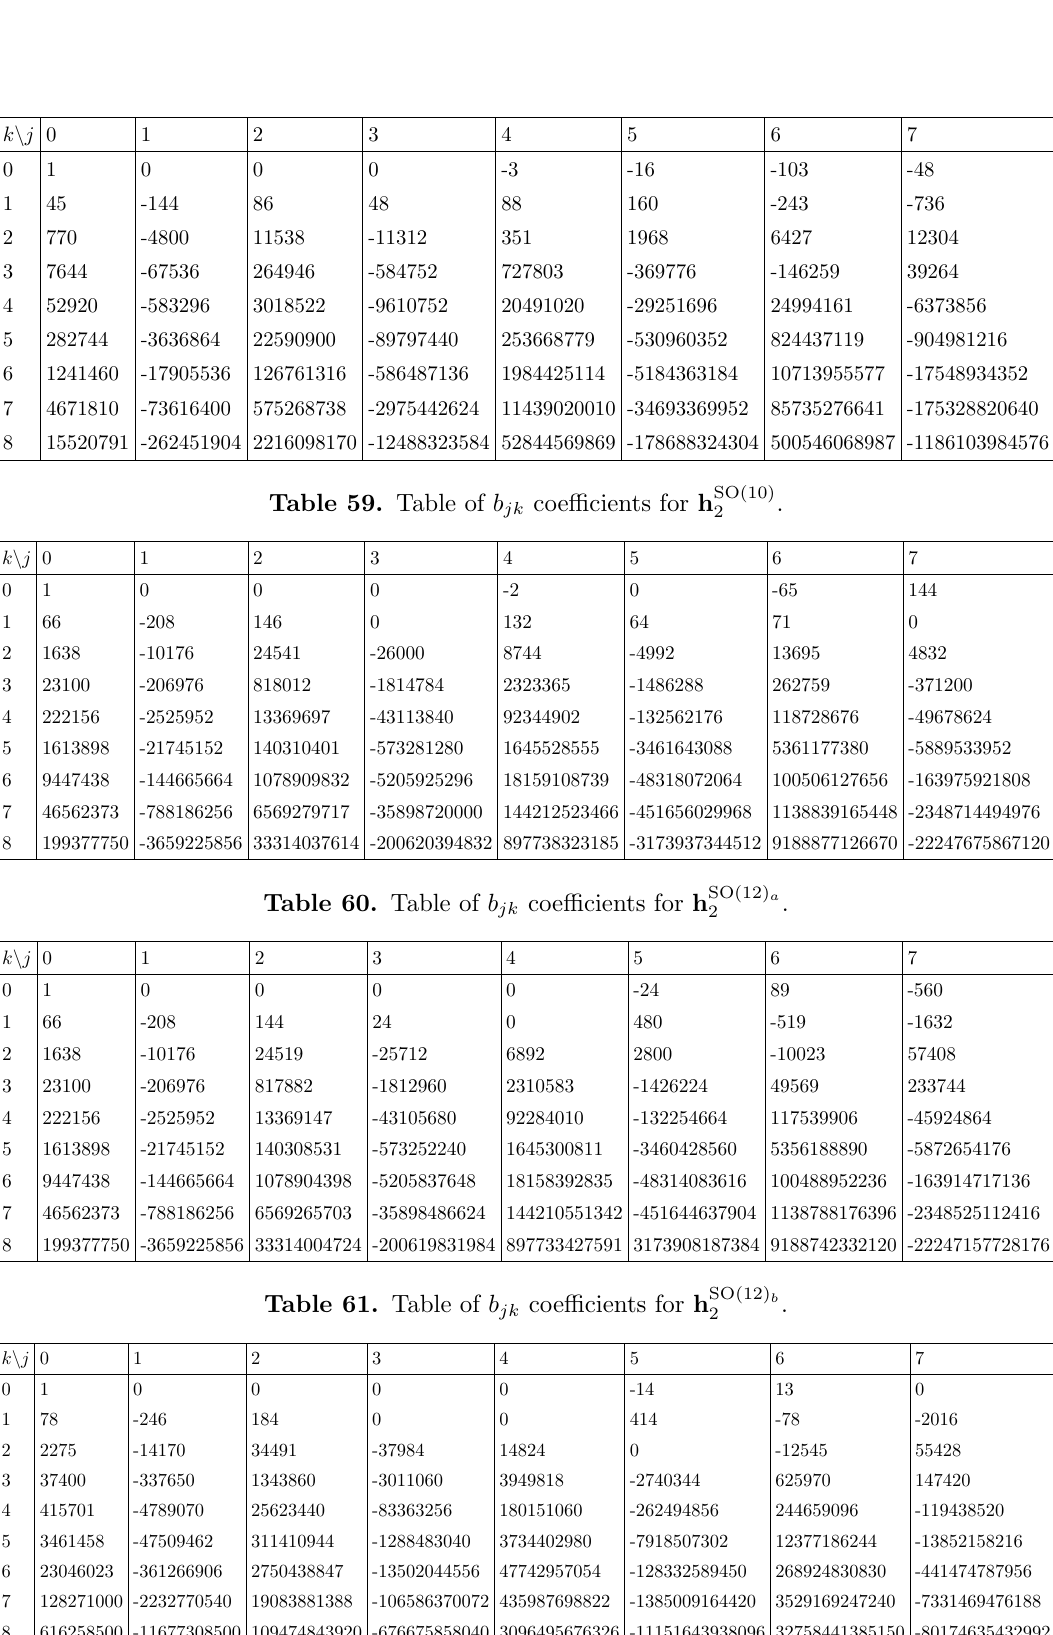
Table 62. Table of b jk coe(cid:14)cients for h SO(13)